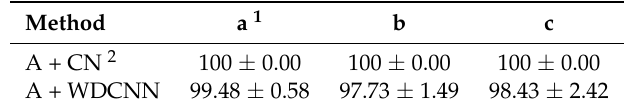
Table 3. Accuracies of different methods tested at the same speed.